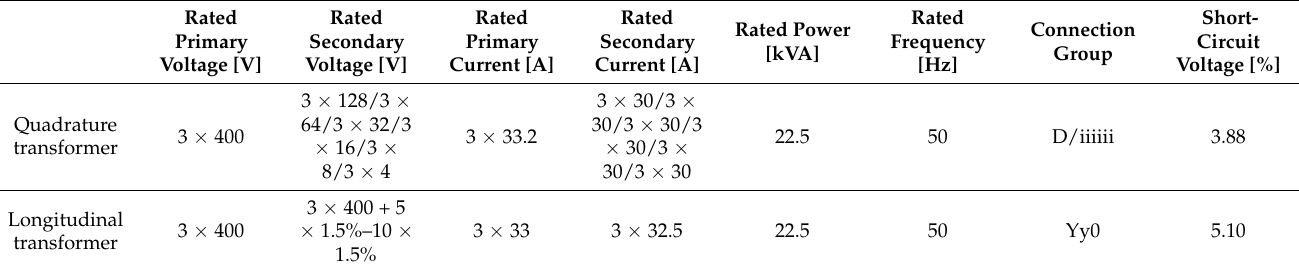
Figure 8. ACPST phasor diagram for minimal and maximal possible longitudinal voltages and maximal quadrature voltage. Table 2. Transformers data.